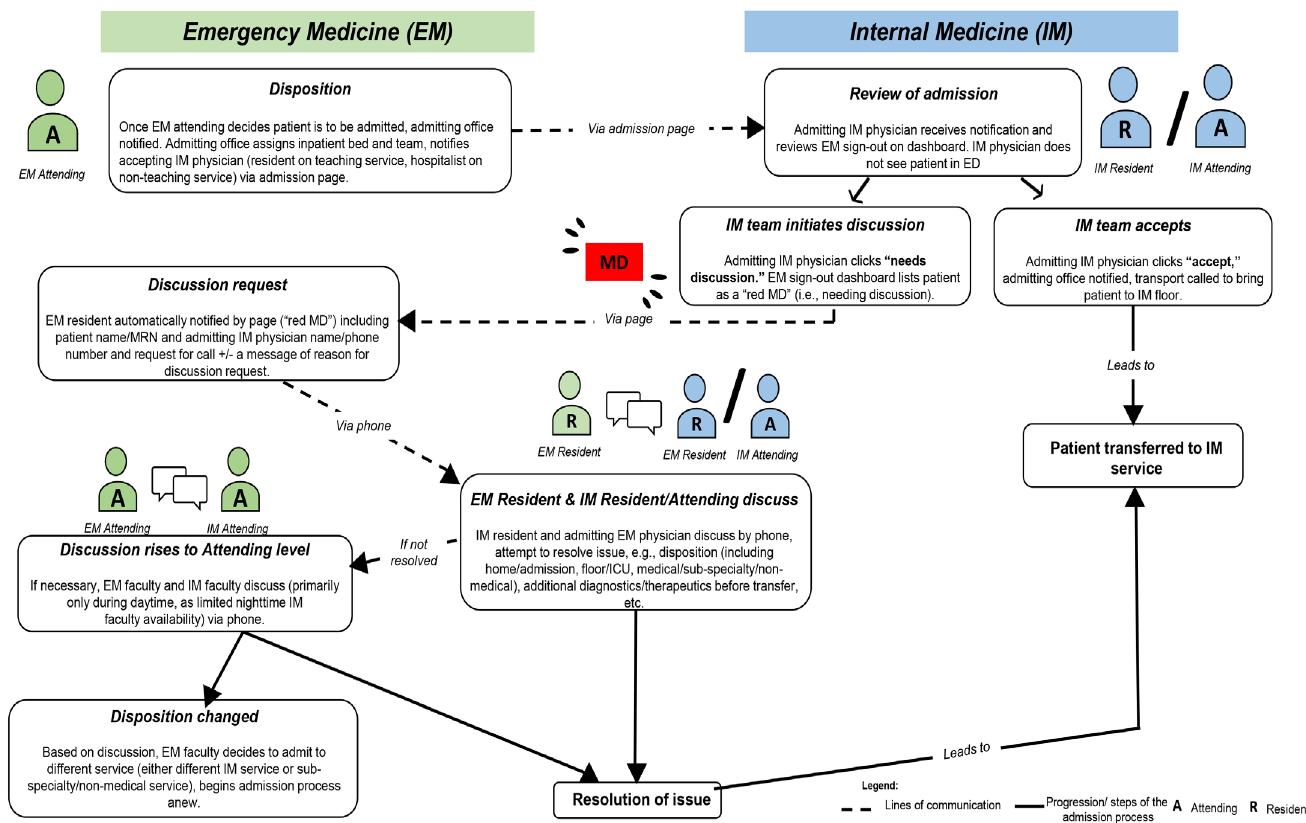
Figure 1. Patient admission process from ED to IM floor. This hospital has designed an electronic signout communication process (e-signout) between EM physicians and admitting physicians through an electronic ED dashboard system. EM attendings decide on need for admission, notify admitting office. Admitting office assigns inpatient bed/team, notifies accepting IM physician via admission page. IM physician (either resident on teaching service, or hospitalist attending on non-teaching service) reviews e-signout and either accepts admission (86% of cases, in which case patient is transferred to IM service) or initiates discussion (14% of cases, in which case a “red MD” notification appears on dashboard and EM resident is notified of need for discussion). If “red MD” case, EM resident and IM resident/attending discuss concerns. If issue is resolved, patient is transferred to IM service. If not resolved, discussion rises to EM attending/IM attending telephone discussion (rare). Issue is either resolved and patient is transferred to IM service or disposition is